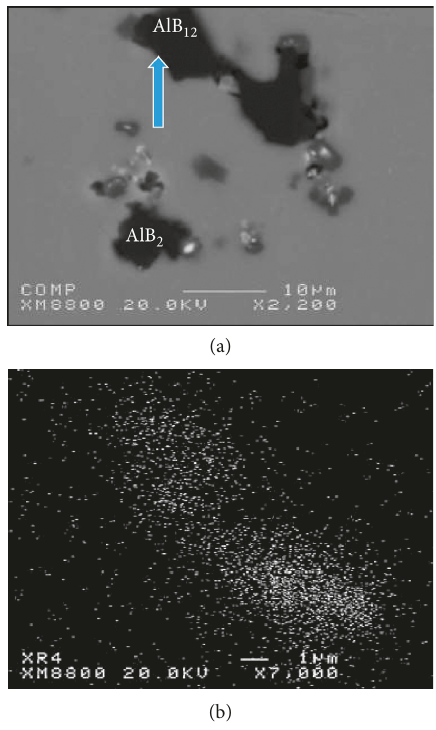
2 and AlB 12 phases observed in